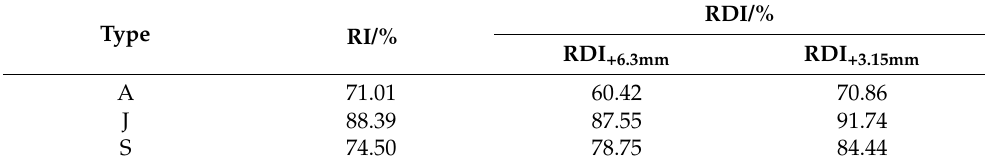
Table 7. Reducibility and low-temperature reduction disintegration index of three lump ores.